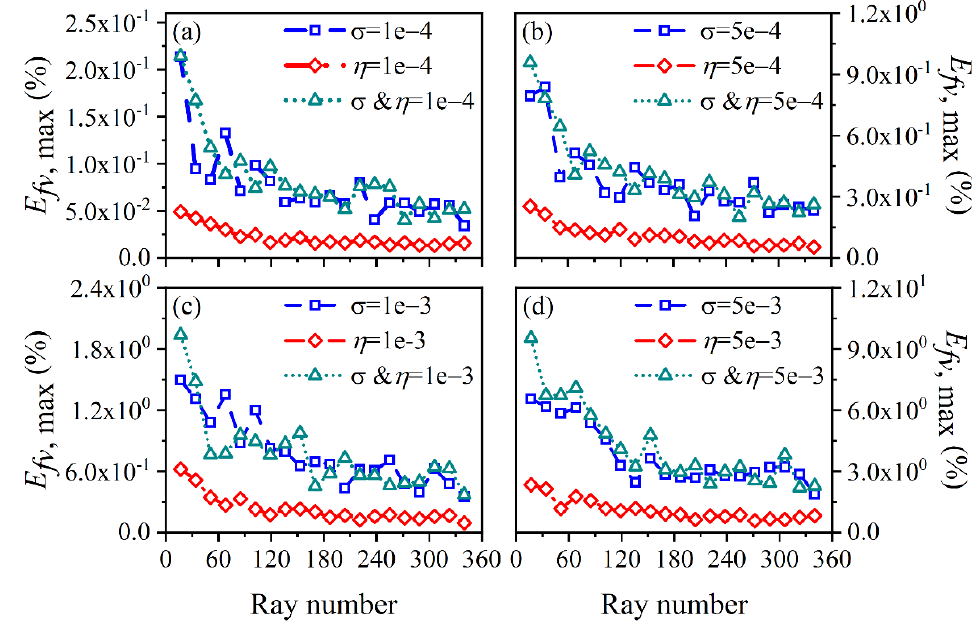
Figure 6. The maximum relative reconstruction error for soot volume fraction under different ray numbers considering the measurement error of the radiation intensity and coefficient matrix. ( a ) SNR = 80 dB; ( b ) SNR = 65 dB; ( c ) SNR = 60 dB; ( d ) SNR = 46 dB. ( a ) SNR = 80 dB; ( b ) SNR = 65 dB; ( c ) SNR = 60 dB; ( d ) SNR = 46